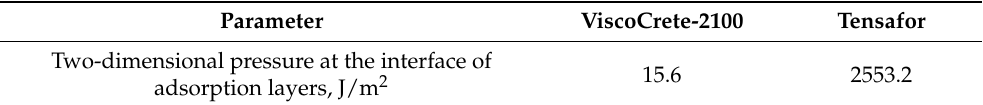
Table 7. Two-dimensional pression at the interface “CNPLUS–surfactant (0.015%)”. Parameter ViscoCrete-2100 Tensafor Two-dimensional pressure at the interface of 15.6 adsorption layers, J/m 2